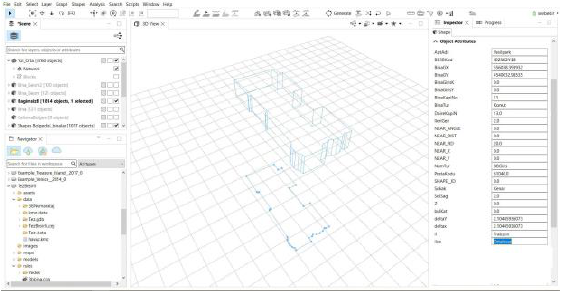
Figure 6. Isolated wireframe view of a building independent